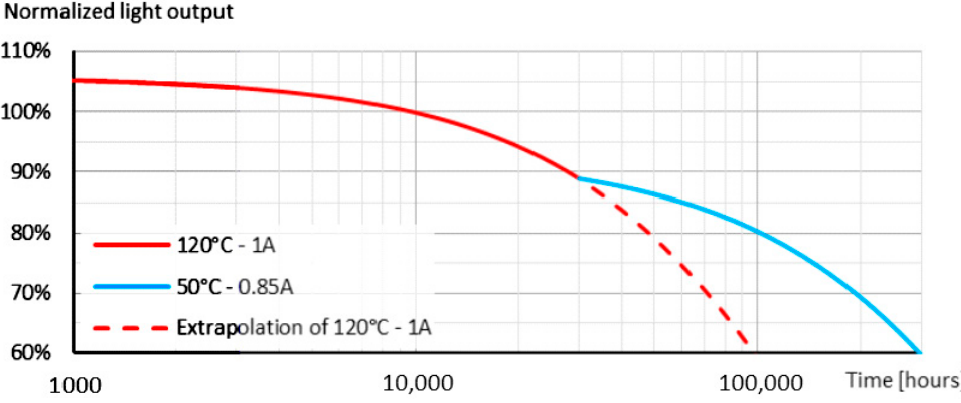
Figure 7. ( a ) Averaged LM-80 measurement results of 9 pieces of Luxeon Z samples and extrapolation until 50k hours ( T J = 120 ◦ C, I F = 1 A); ( b ) Exponential curve fit to the LM-80 measurement set along with the eight assumed aging trends.